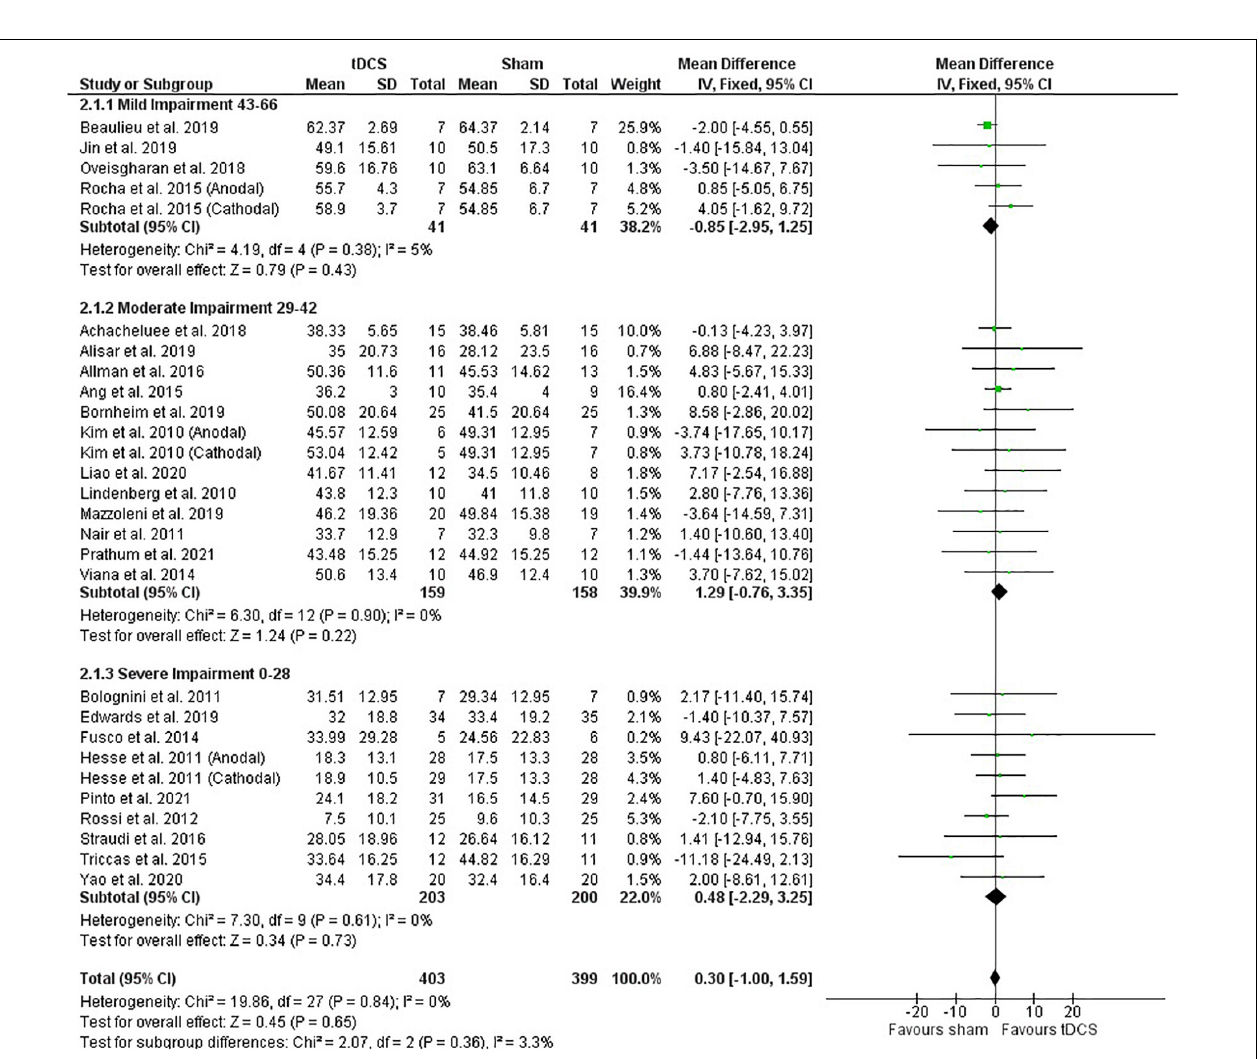
FIGURE 2 | Effects of tDCS on stroke recovery as assessed by the post-intervention data of the tDCS and sham groups for the upper extremity Fugl–Meyer Assessment.